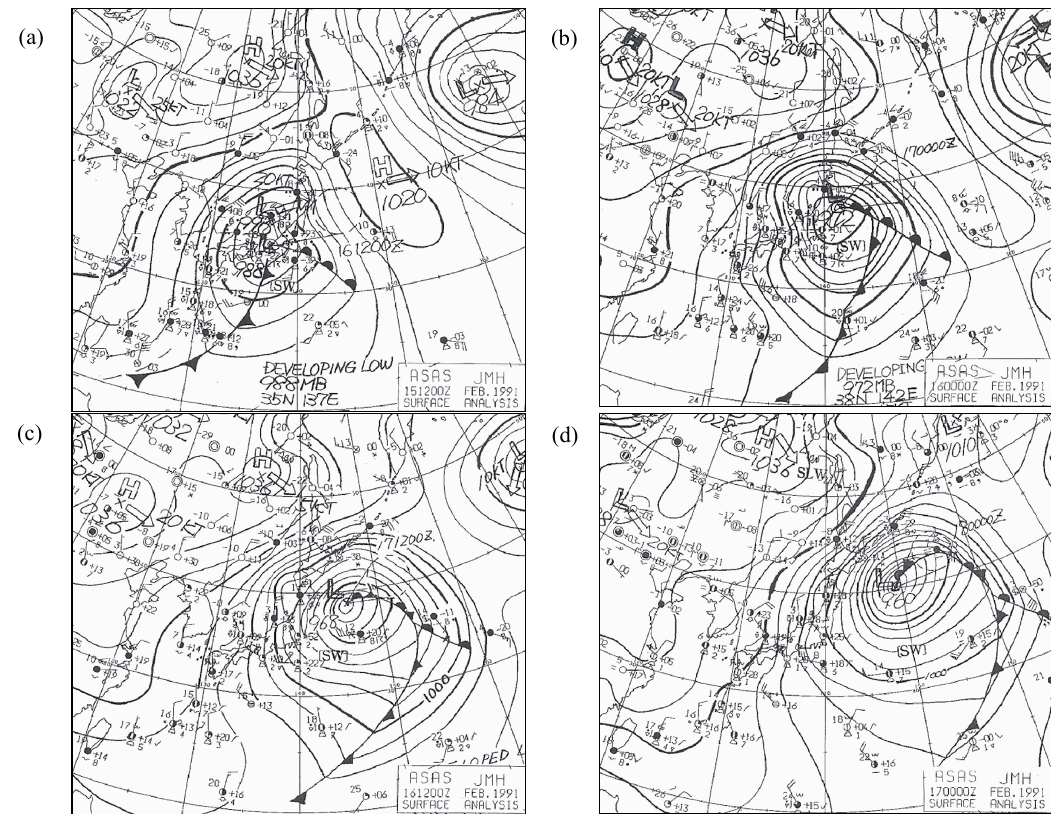
Fig. 6. Weather charts for twelve hour increments from 12:00 UTC 15 February to 00:00 UTC 17 February 1991 (from JMA).